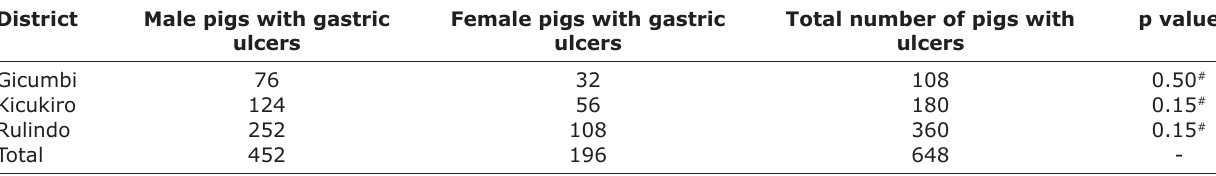
*Significant difference between number of males and females slaughtered (p<0.05) Table-2: Occurrence of gastric ulcers in slaughtered pigs according to district and sex. District Male pigs with gastric ulcers